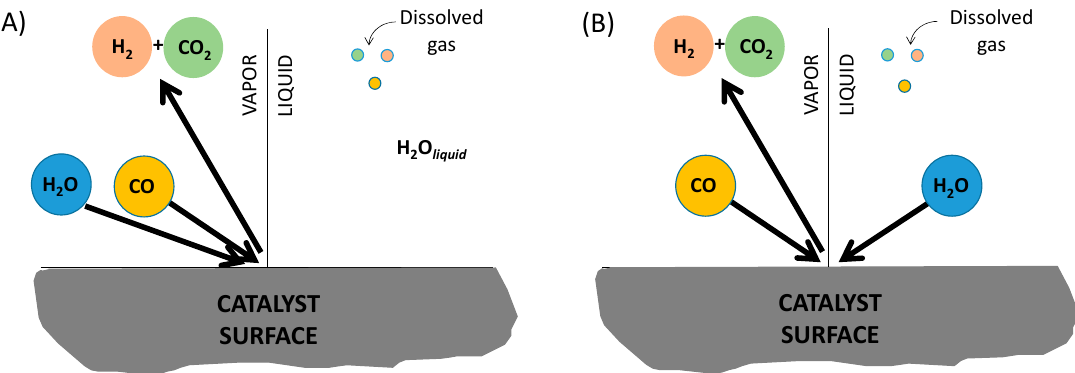
Figure 6. Schematic representation of the water–gas shift (WGS) reaction mechanisms for aqueous-phase reforming (APR) reacting H 2 O from liquid ( A ) or vapor ( B ) phase.